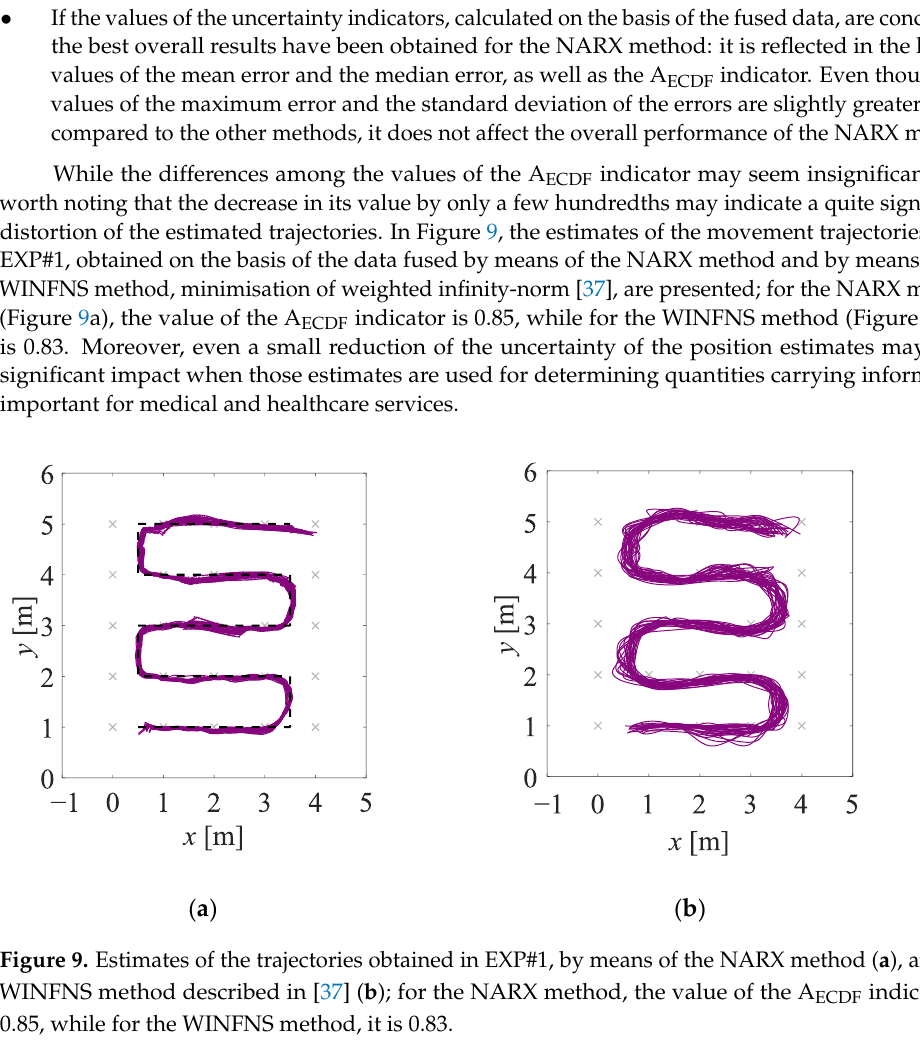
A indicator E C D F